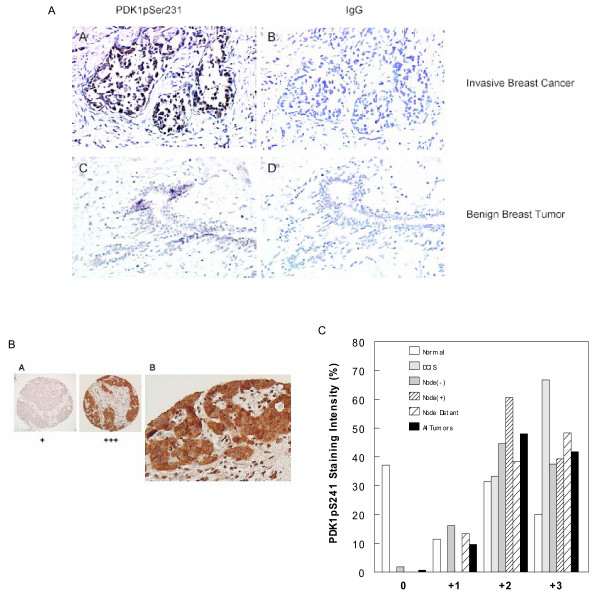
Immunohistochemical detection of PDK1pSer241 in breast cancer specimens. A, IHC for PDK1pSer241 in paraffin blocks of benign (C,D) and malignant (A,B) breast tissue. Staining was conducted with either nonimmune IgG (B,D) or a PDK1pSer241 antibody (A,C). B, Tissue microarray cores of low (+) expressing and high (+++) expressing breast cancers stained for PDK1pSer241. PDK1pSer241 was abundant in both the cytosol and nucleus of the carcinoma. C, A bar graph depicting the results in the tissue microarray analysis of 177 evaluable cores expressing either no (0), low (+1), medium (+2) or strong (+3) PDK1pSer241 staining of normal (normal), DCIS (DCIS), node negative (node (-)), node positive (node (+)) and metastatic (node distant) breast carcinomas.